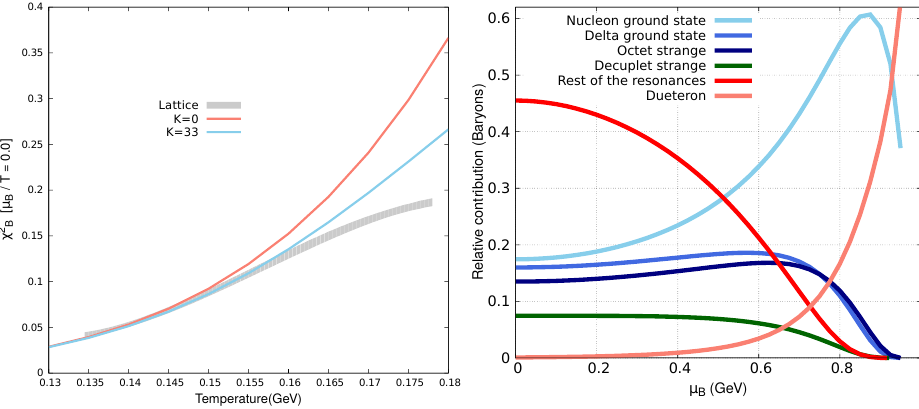
Figure 3. (Left) The second-order baryon number fluctuations compared between mean-field and 2 + 1 flavor QCD with physical quark masses obtained from the lattice. (Right) Variation of the relative abundance of baryons along the phase line. x axis denotes the µ B , calculations are performed with the corresponding T c